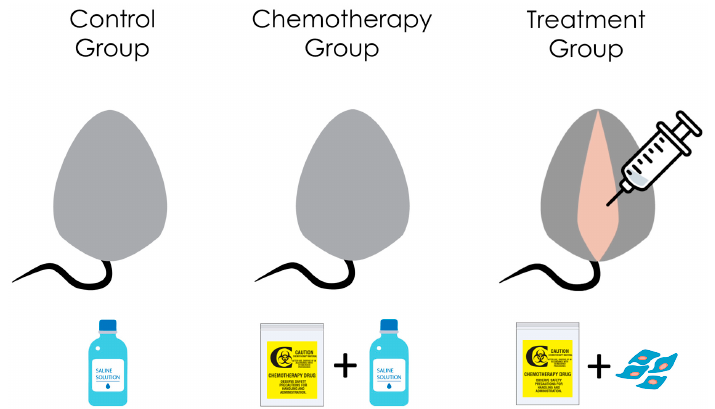
Figure 1. Illustrates different experiment groups: (1) Control group, no chemotherapy is given, (2) chemotherapy group, and no stem cell therapy, only saline was injected, (3) treatment group, the test group, where stem cells were injected in both